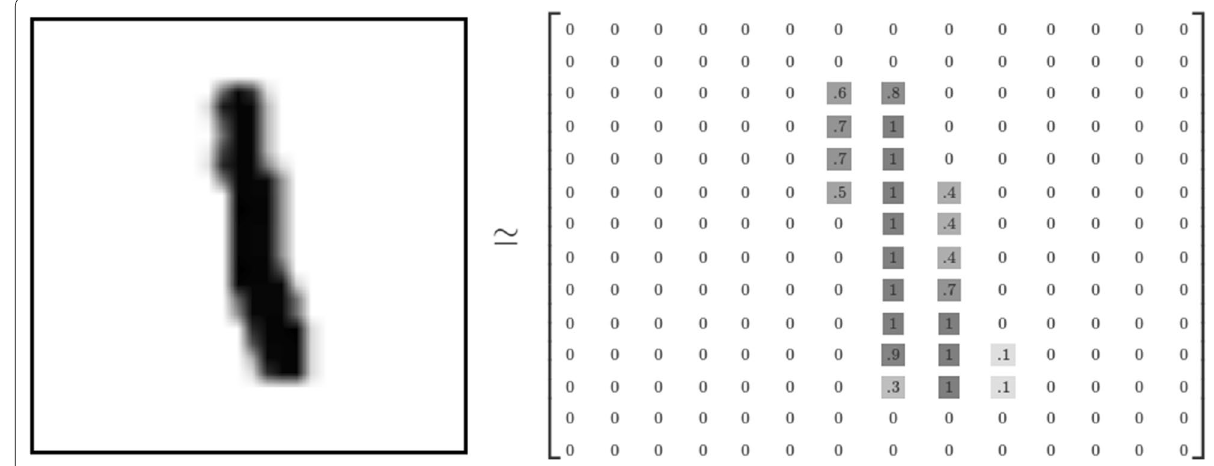
Fig. 2 Matrix representation of a 8‑bits black and white image. The values range from 0 to